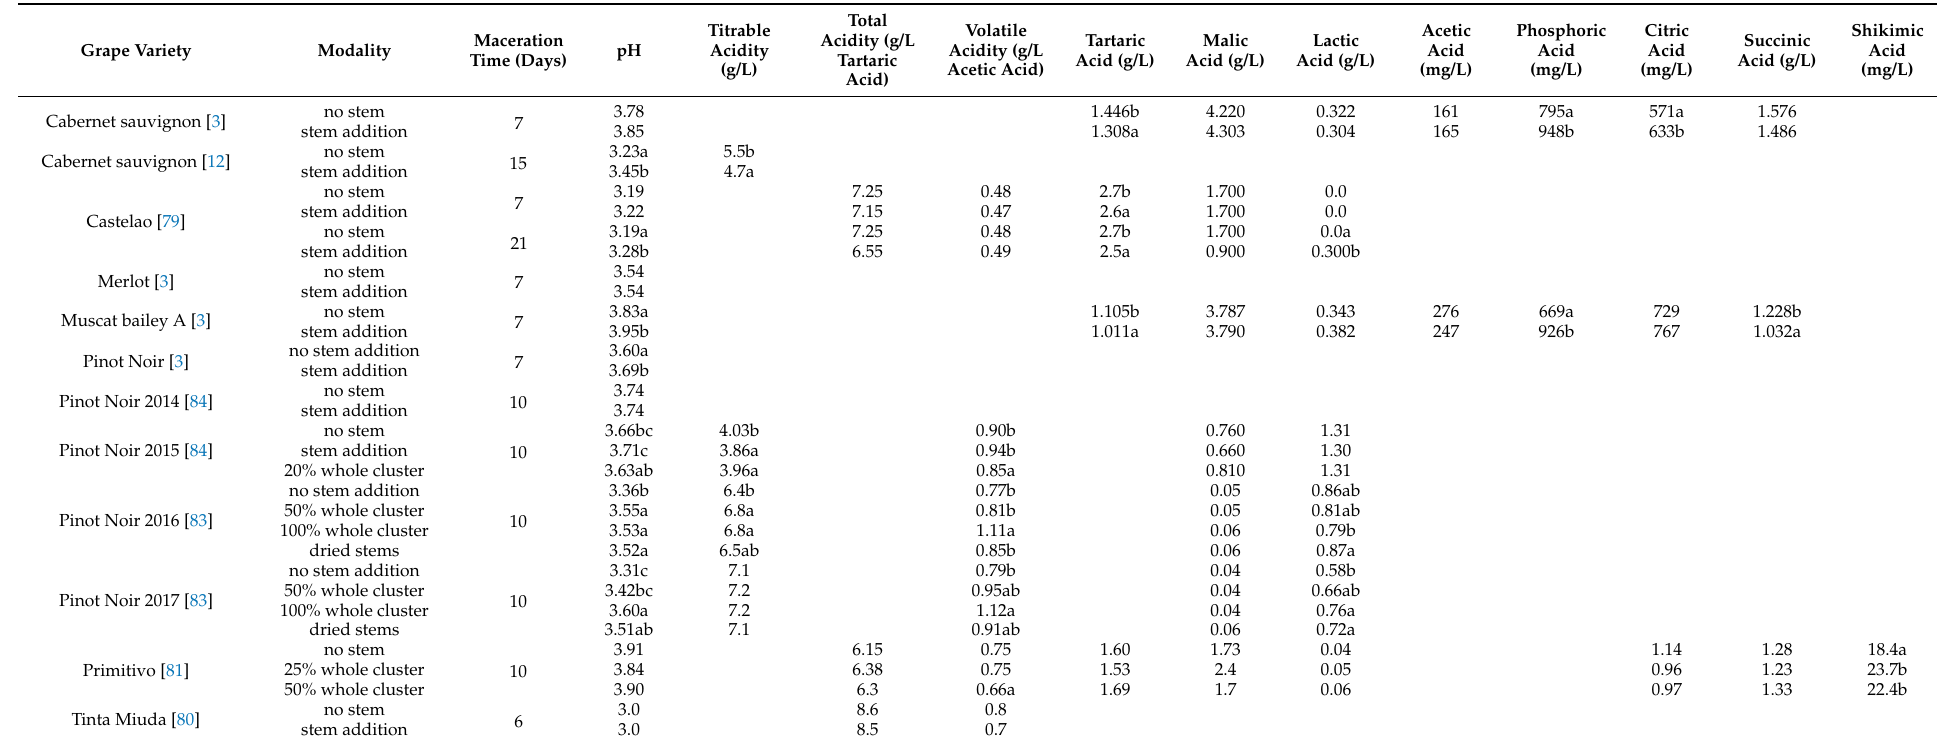
Table 12. pH and acidic composition of wine made with and without stem addition (for each study, different letters indicate significant statistical